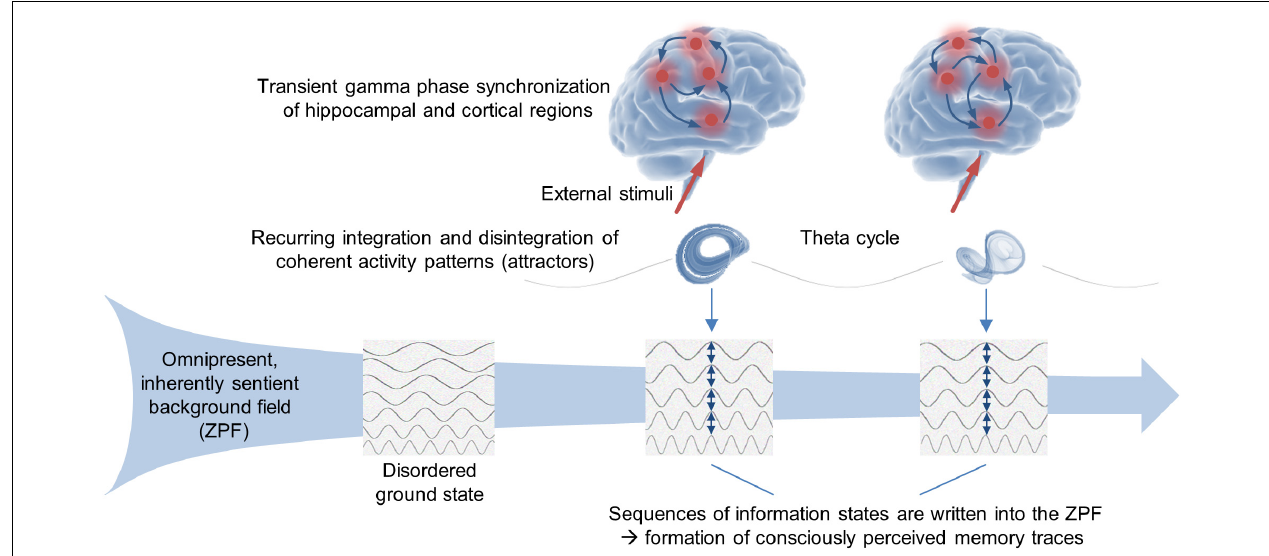
FIGURE 2 | Stimulus-oriented operating mode of the brain. A huge body of empirical evidence suggests that declarative memory formation and conscious perception are based on one and the same fundamental mechanism. Concretely, an episodic memory trace is partitioned into a sequence of events. The encoding of each individual event relies on transient gamma phase synchronization of hippocampal and cortical regions, while the periodic integration and disintegration of the synchronized activity patterns (attractors) is reflected in the theta rhythm. From the perspective of the SED-based conceptual framework, each attractor formation is accompanied by a persistent, attractor-specific ZPF information state that is associated with a specific conscious state. Accordingly, the experimental findings support the hypothesis that in the stimulus-oriented operating mode the brain produces consciously perceived memory traces by writing sequences of information states into the